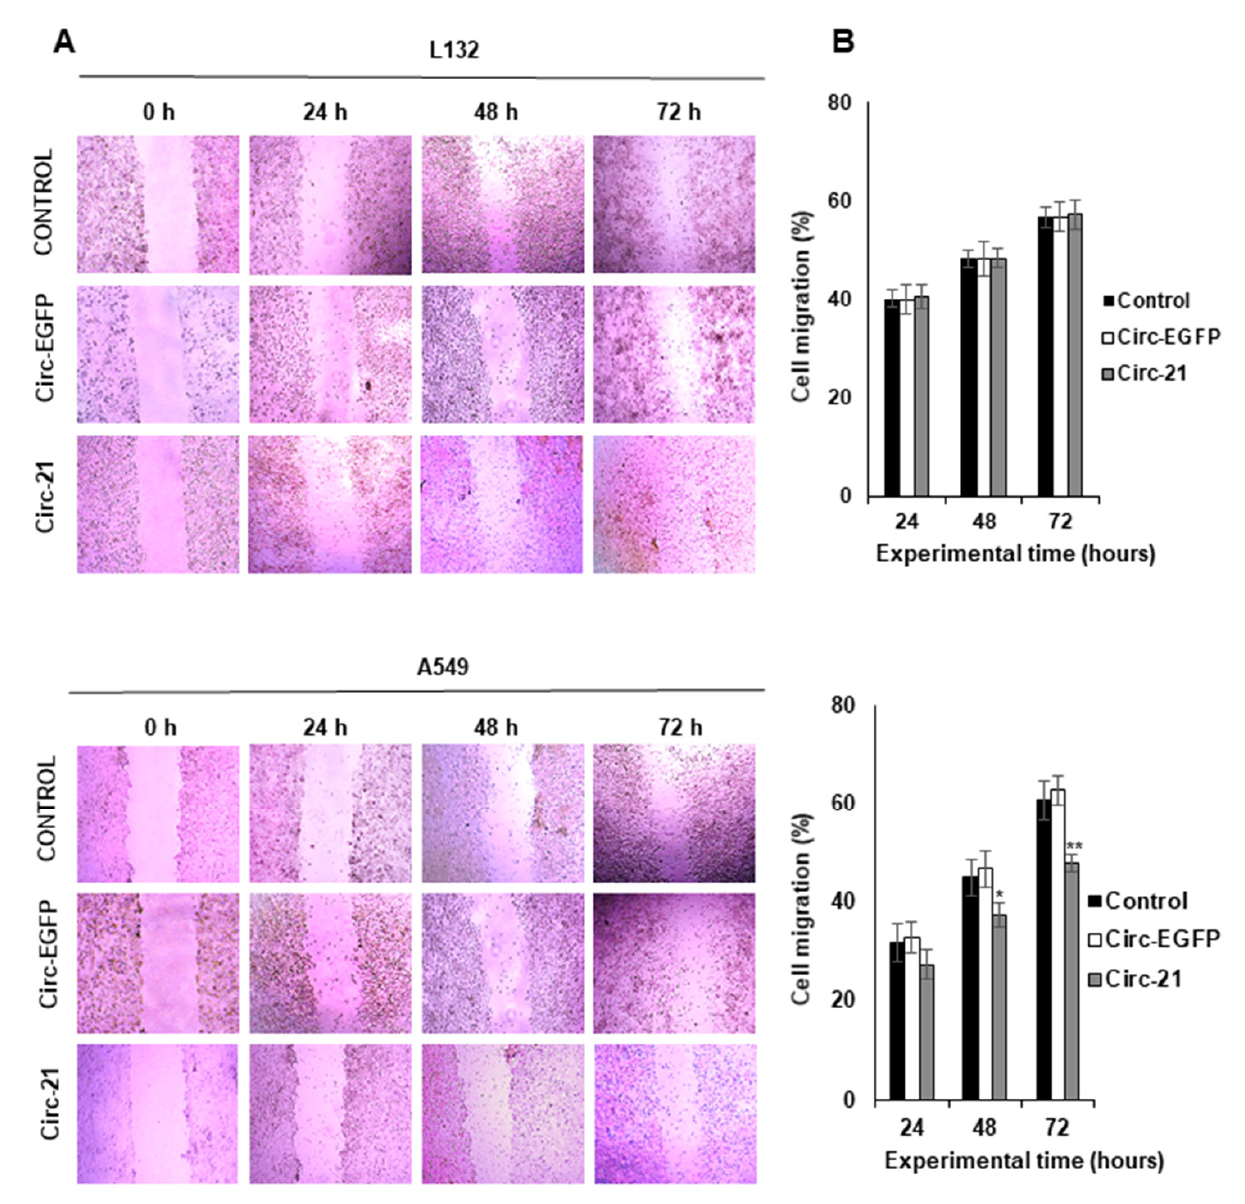
Figure 5. The Circ-21 sponge inhibited lung cancer cell migration. ( A ) Representative microscopy images of wound-healing assays; ( B ) Graphic representation of the percentage of lung cancer cells tumor migration (area of the scratch). Values represent means ± SD of triplicate cultures. Statistical analysis was performed using a two-tailed t -test comparing the different samples against the control. * p < 0.05 and ** p < 0.01. Only statistically significant differences are shown and indicated with asterisks.